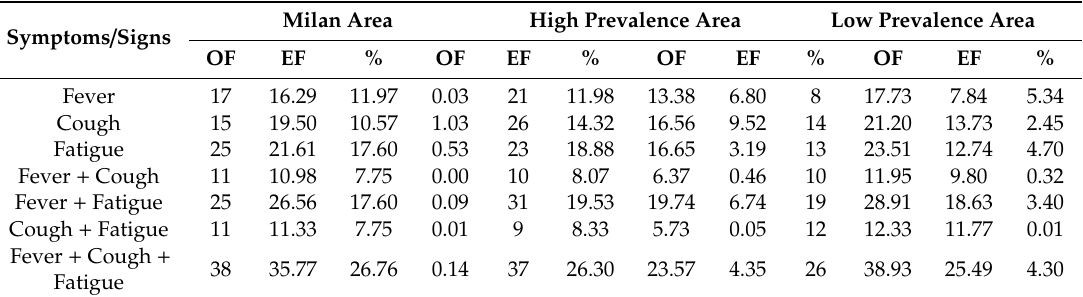
Table 4. Prevalence of the most associated symptoms / signs related to the COVID-19 in the di ff erent Lombardy provinces. Percentages were calculated per column. Milan Area High Prevalence Symptoms / Signs